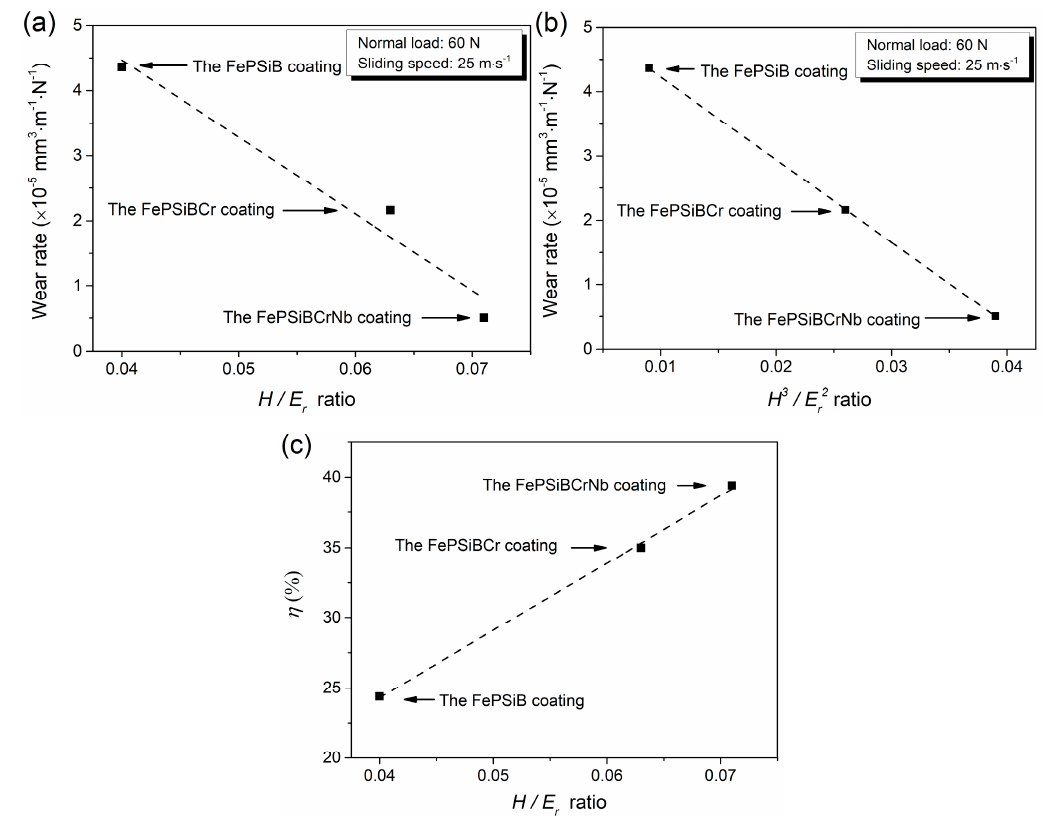
Figure 8. ( a ) the relationships between the H/E r ratio and wear rate; ( b ) the relationships between the H 3 /E r 2 ratio and wear rate; and ( c ) the relationships between the H/E r ratio and η